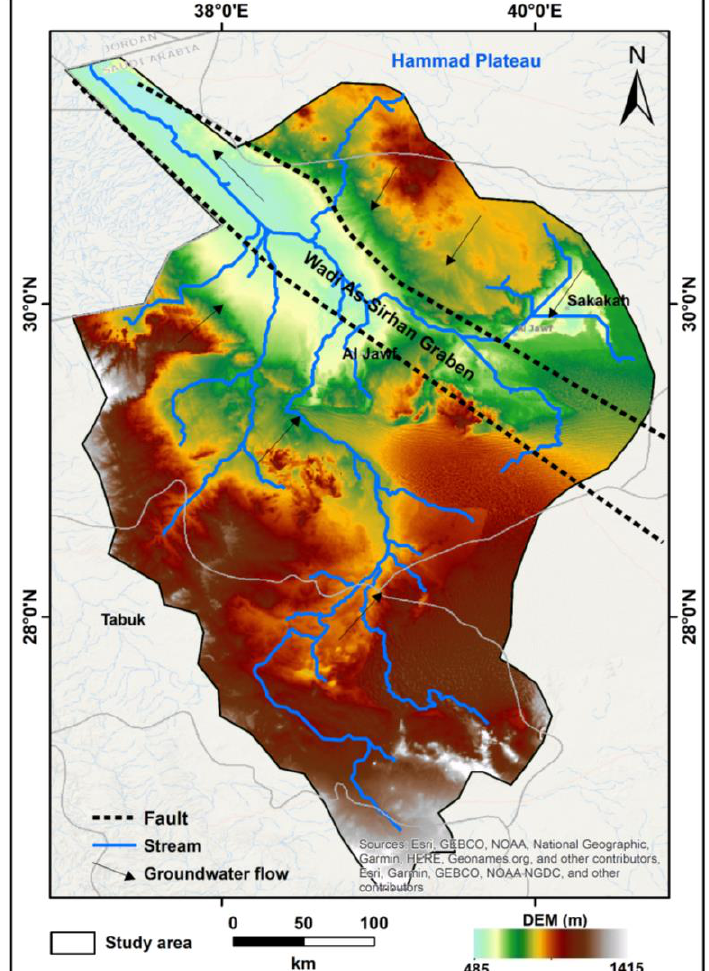
Figure 10. The DEM’s elevation map of the ground’s surface. Additionally depicted are the region’s tributary systems.